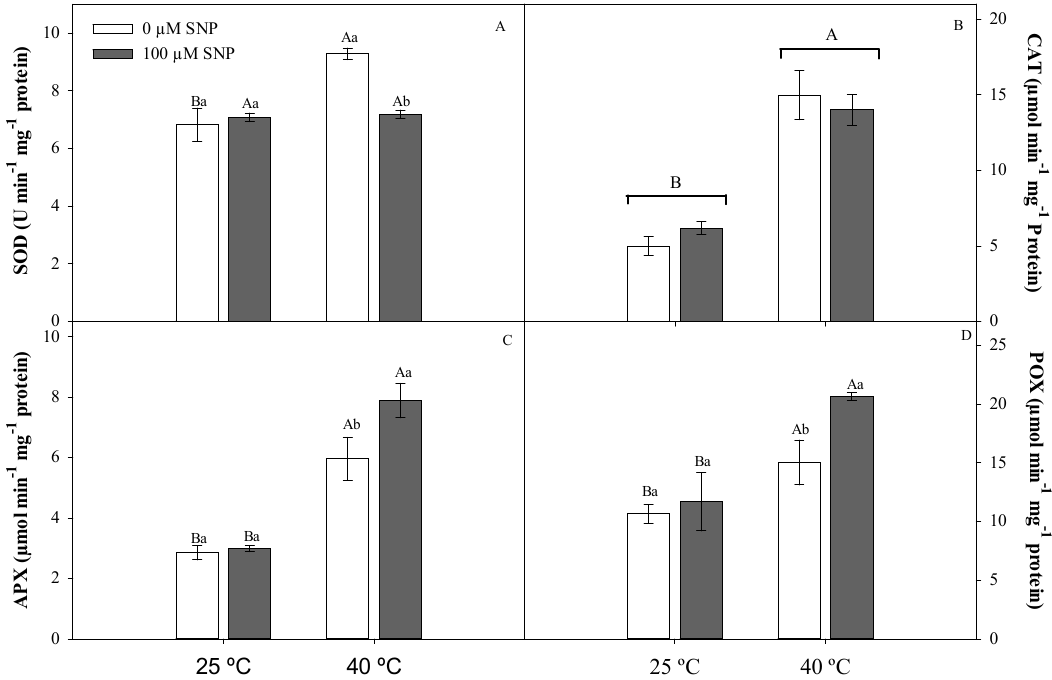
Figure 7. Dismutase superoxide (SOD, A ), catalase (CAT, B ), ascorbate peroxidase (APX, C ), and total peroxidase (POX, D ) activities in soybean plants submitted to two temperatures (25 °C and 40 °C) and two SNP concentrations (0 and 100 µ M). Bars represent means ( n = 5) ± SE. Capital letters (between temperatures) and lowercase letters (within temperatures) represent significant differences using Tukey’s test ( p < 0.05).